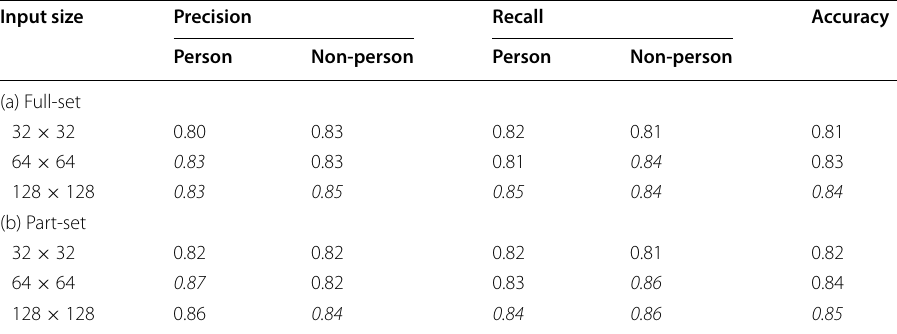
Table 4 Evaluation with dataset